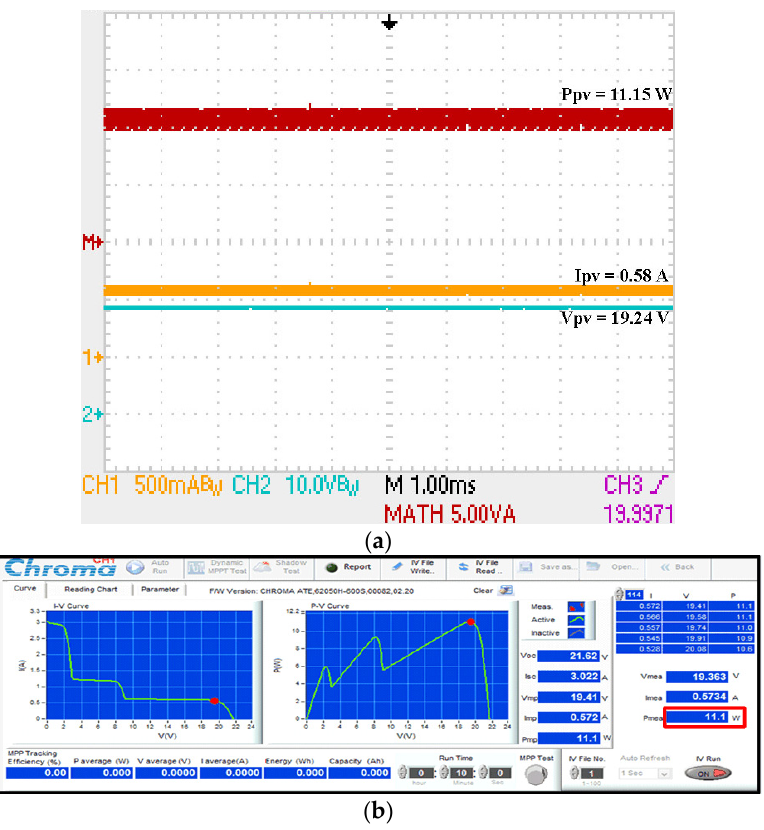
Figure 24. Experimental results under PSC 2 of the proposed modified LFO, ( a ), ( b ) reflect same result.